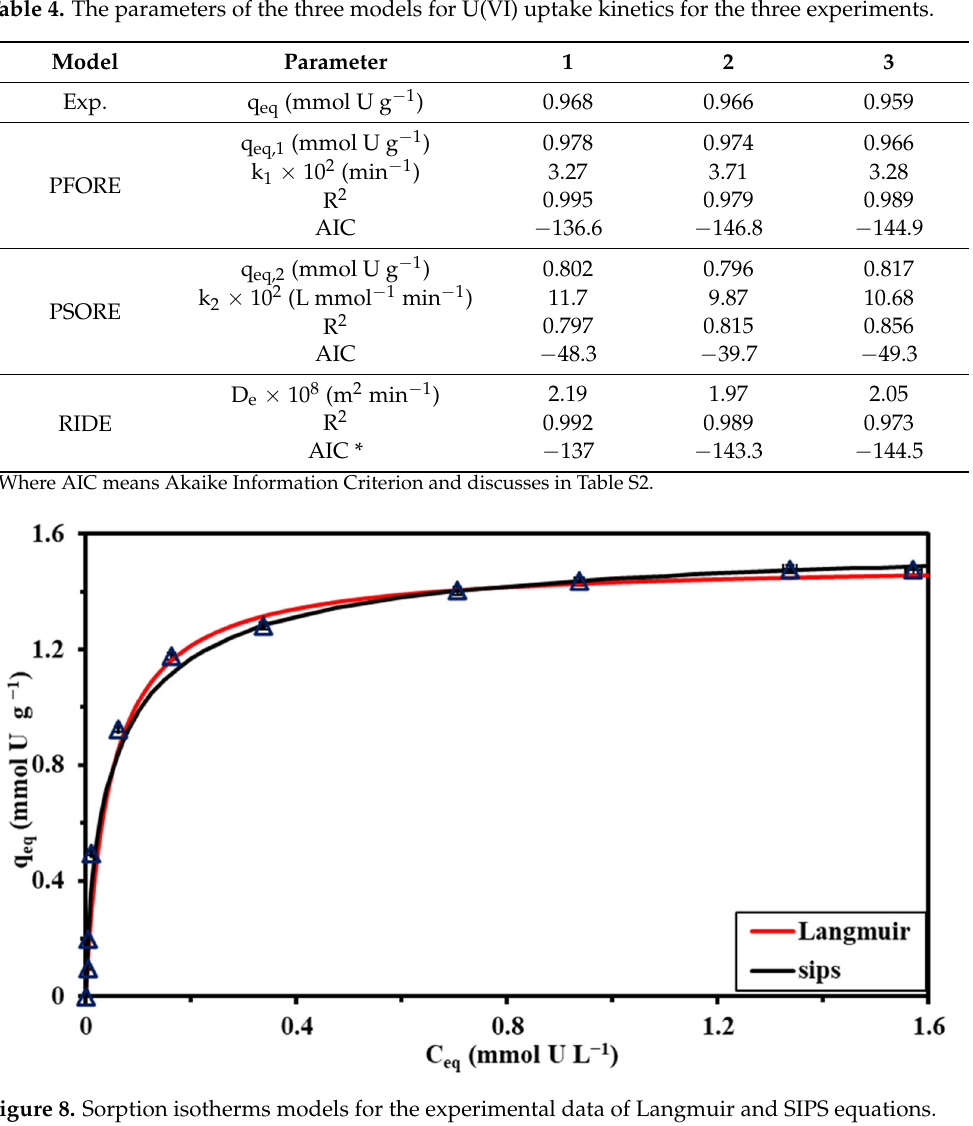
Table 6. U(VI) sorption properties of alternative sorbents.